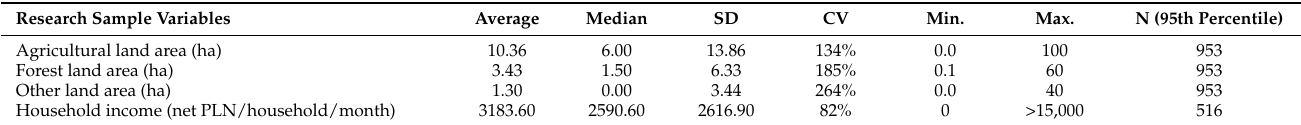
Table 1. Characteristics of researched farms established by survey conducted in April 2019 based on random representative nationwide sample of forest owners (farmers).